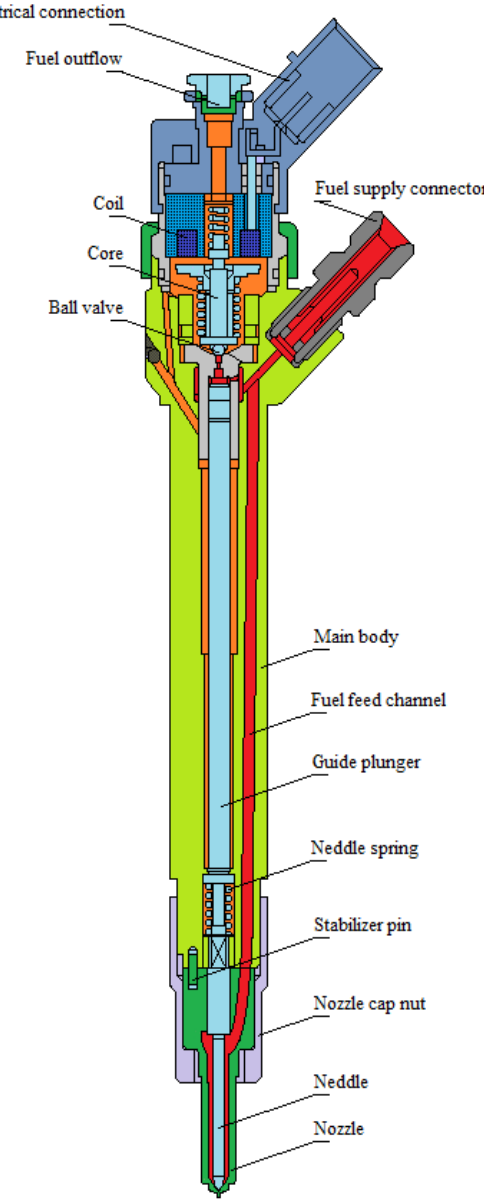
Fig. 1. CRI1 Bosch fuel injector